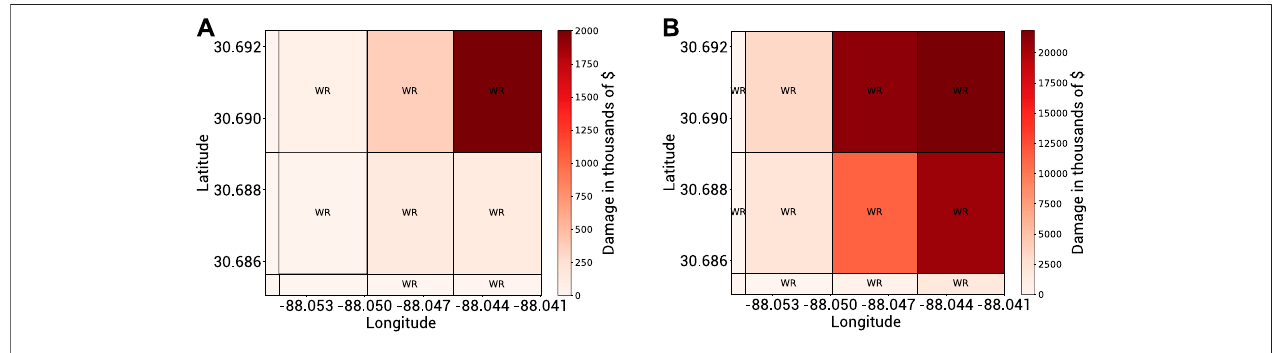
FIGURE 17 | Expected losses for scenarios (A) S KN2100-8.5 and (B) S KS2100-8.5.